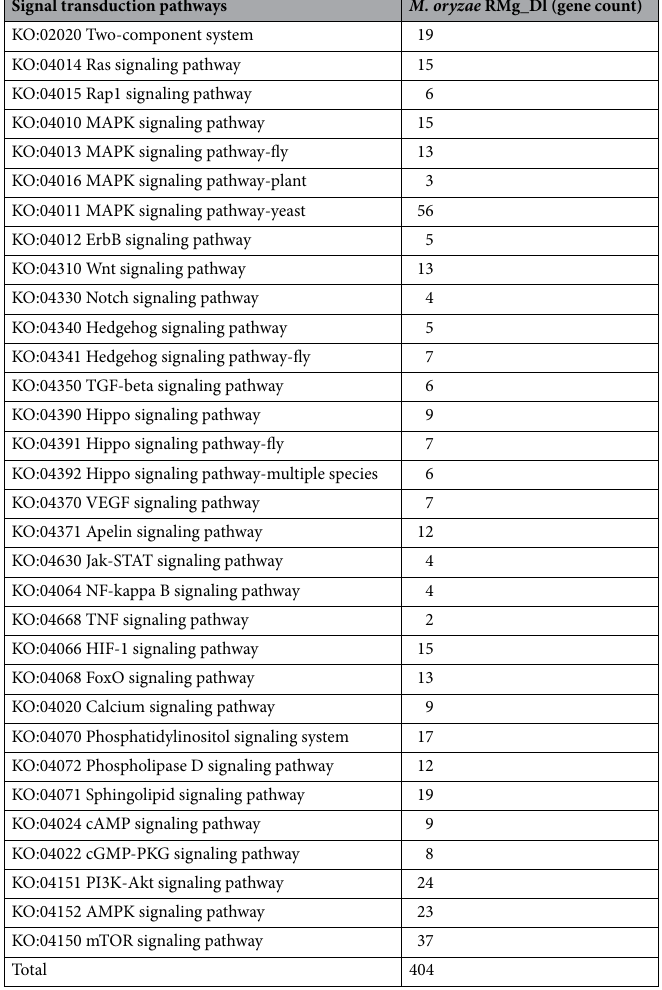
Table 5. Signal transduction KEGG (Kyoto Encyclopedia of Genes and Genomes) pathway for M . oryzae